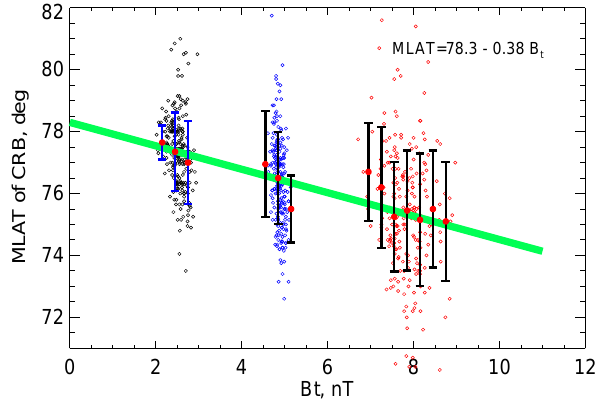
Figure 9. MLAT of the convection reversal boundary location in the dusk sector. Black, blue and red points (small diamonds) cor- respond to the RG-96 model bands, cases A, B and C (Table 1), respectively. Large red circles are the binned values of the magnetic latitude made with a step of 0.3nT. Vertical bars are the median value of the CRB location within each bin ± one standard deviation from the median value. The green line is the best linear fit line to all the points. The y -intercept and the slope of the line are shown in the upper right corner. Table 2. Y -intercept and slope of the linear fit to the MLAT- B − t dependence for a number of B − t bands as described in Table 1. Data in the three left columns characterize the fits within specific RG-96 model bands (in Fig. 9, fits to red dots within each RG-96 model band). Data in the three right columns are obtained by fitting to all available points (in Fig. 9, black, blue and red small